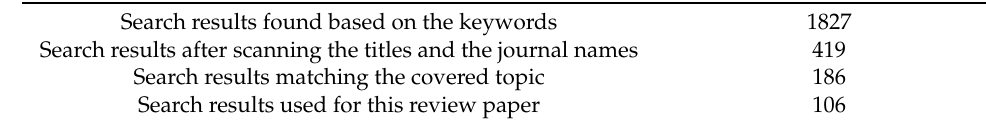
Table 1. Successive reduction of search results for papers and